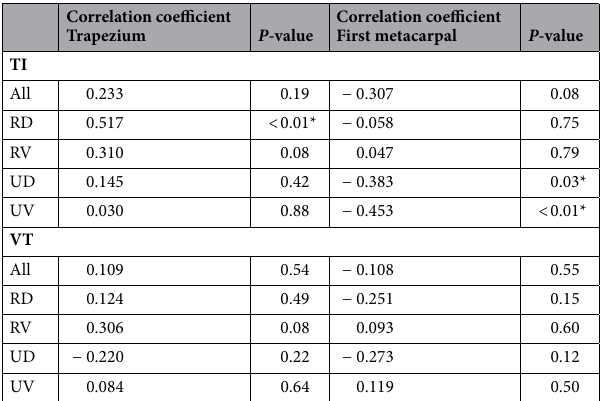
Table 3. Correlation coefficients between percentage of the high-density area and trapezial inclination or volar tilt. TI trapezial inclination, VT volar tilt. * P <